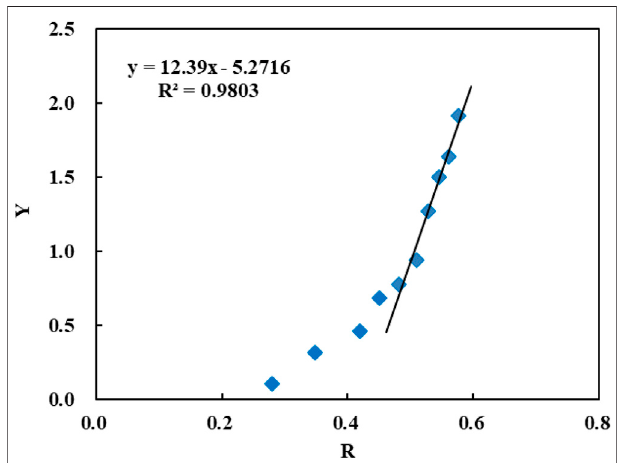
FIGURE 2 | The relation curve of Y~R.